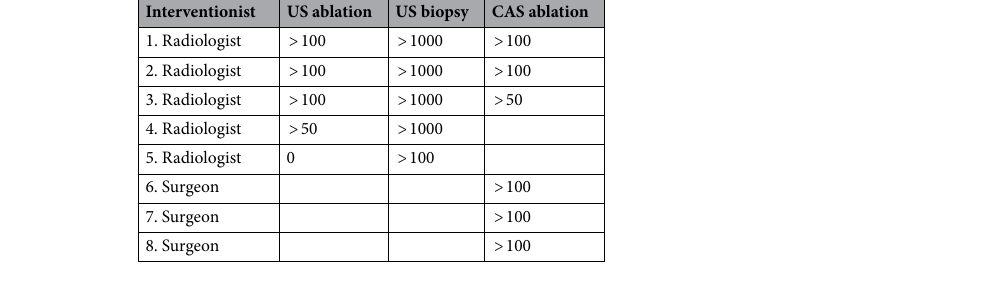
Table 1. Interventionist: speciality, and previous experience.